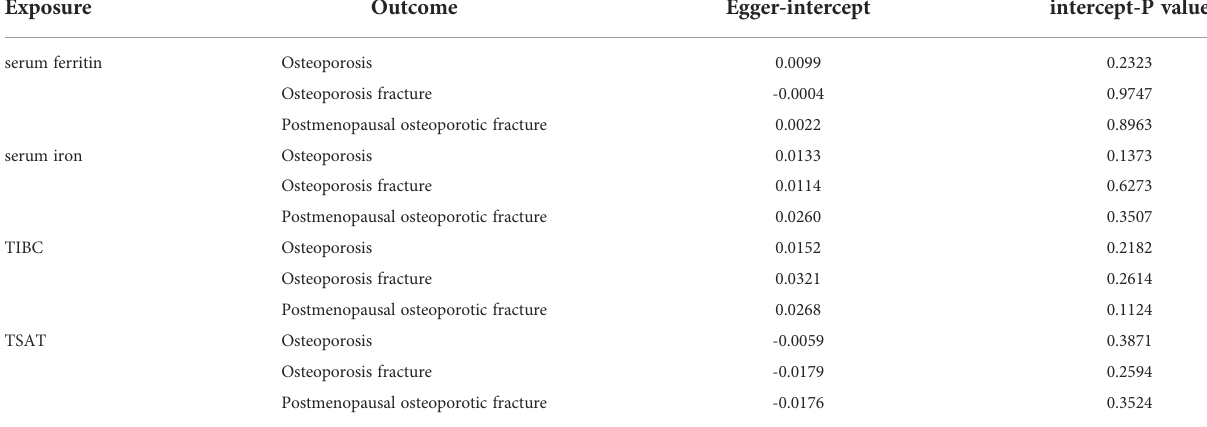
TABLE 2 MR-PRESSO analysis and MR-Egger intercept.